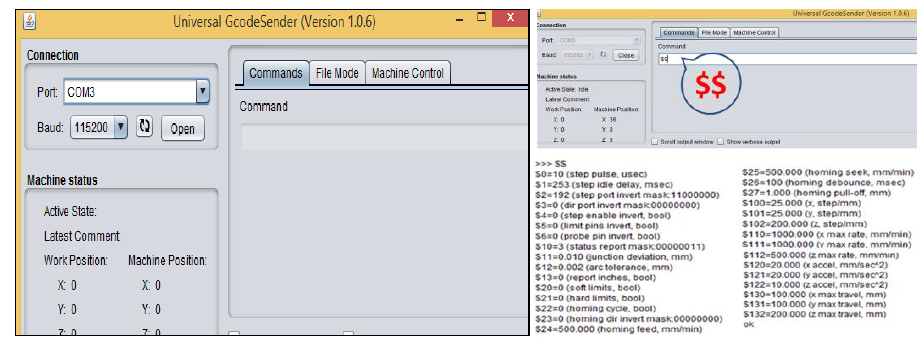
Figure 9. Universal Gcode Sender.